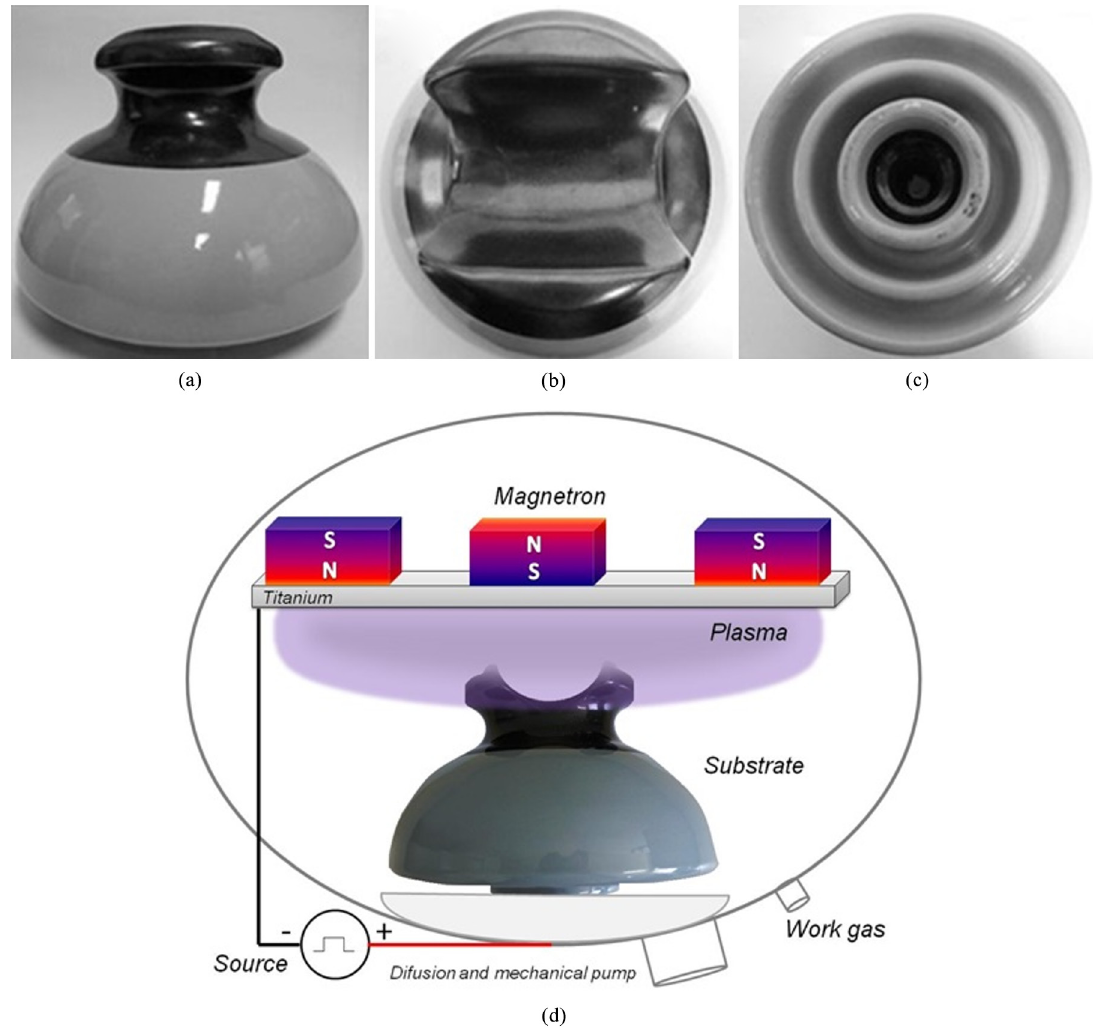
Figure 1. Photograph of the insulator used as the substrate. (a) Side view. (b) Top view. (c) Bottom view. (d) The deposition equipment schematic